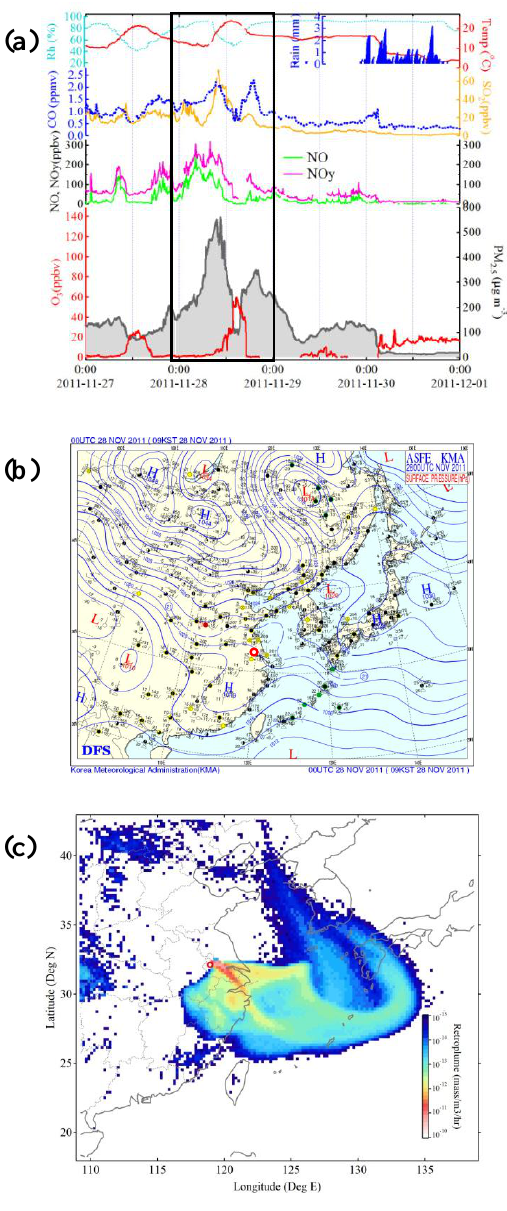
Figure 8. Same as Fig. 7 but for Case II, i.e. 27-30 November 2011. 2 Fig. 8. Same as Fig. 7 but for Case II, i.e., 27–30 November , PM , related trace gases and meteorological parameters for 2 3 2.5